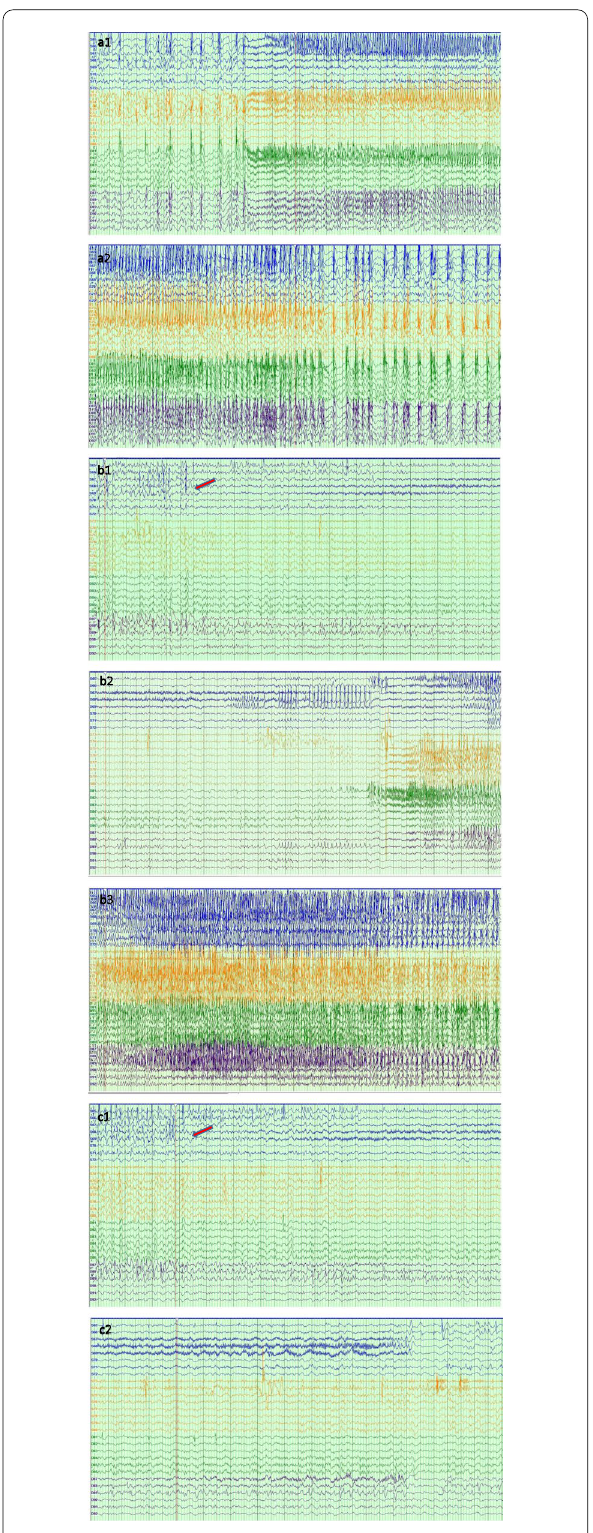
Fig. 4 Intracranial EEG monitoring. a 1 2.‑ Seizure occurring 10 + h after implantation. Cessation of interictal activity and a burst of LVFA evolving into rhythmic high voltage spike activity. Note the simultaneous onset of seizure in all regions involved. b 1‑3. Seizure occurring from 24 h after impanation before readministration of ASM. Cessation of interictal activity, seizure onset of LVFA in the temporal pole (arrow) occurring 45 s before involvement of the PHG, and Hippocampus. c 1‑2. Seizures occurring after readministration of ASM‑ Habitual seizure onset with LVFA in the temporal pole (arrow) ‑ last for 47 s without involving other regions and without apparent clinical signs. Referential montage: S65‑S72, Temporal pole strip; S73‑S80, PHG strip; D81‑D83, AH electrodes; D84‑D86, MTG electrodes; D87‑D89, PH electrodes; D90‑D92, Posterior MTG. Time scale, 15 mm/s; sensitivity, 50 μv/mm; filter band pass, 0.5‑70 Hz.